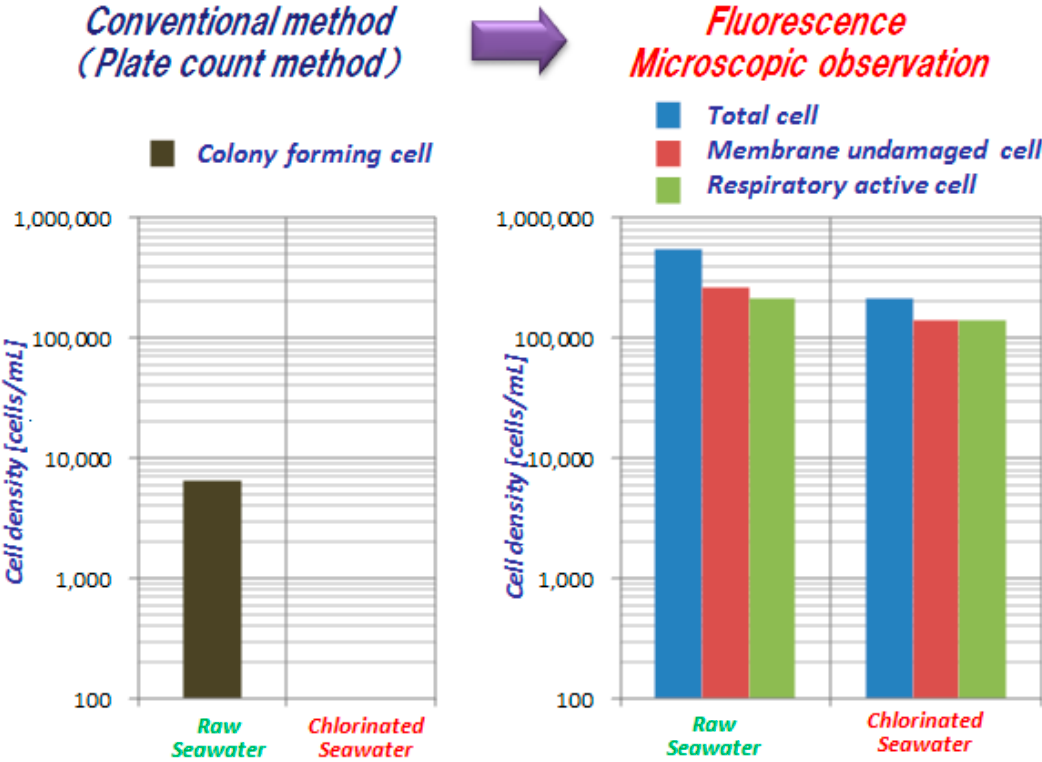
Figure 5. The sterilization effect by chlorination is limited.